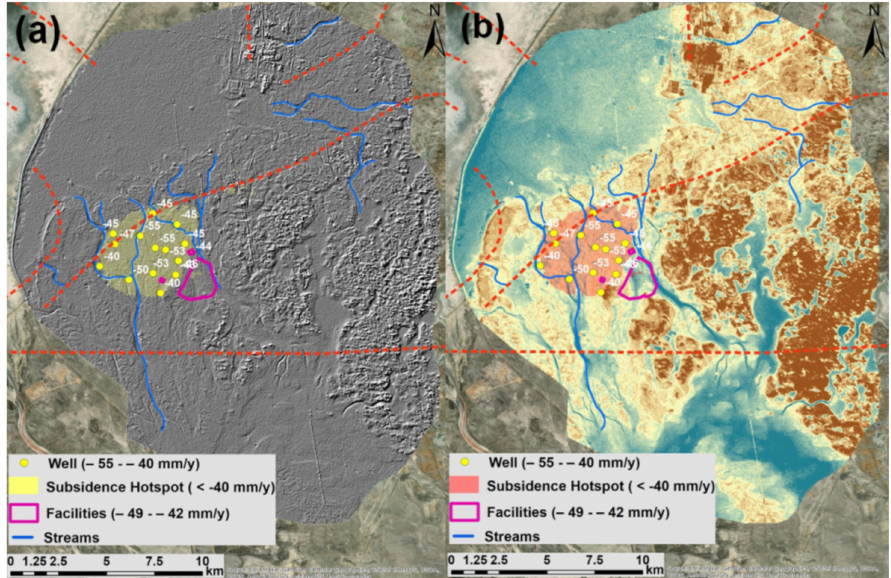
Figure 16. ( a ) Terrain Hillshaded representation with Wells and Facilities; ( b ) DEM with Wells and Facilities falling between − 55.6 mm/year and − 42